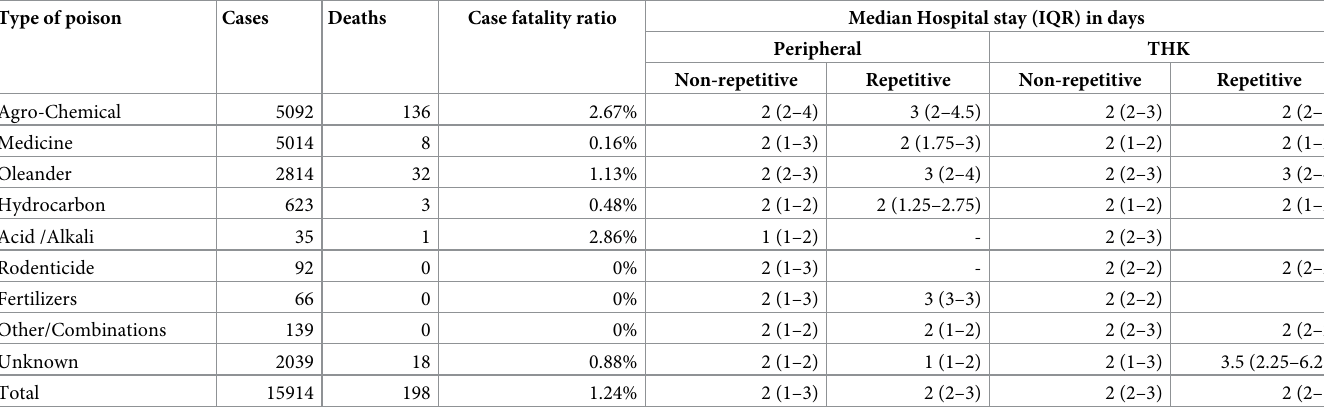
Table 4. Duration of hospital stay and case-fatality ratio by type of poison.